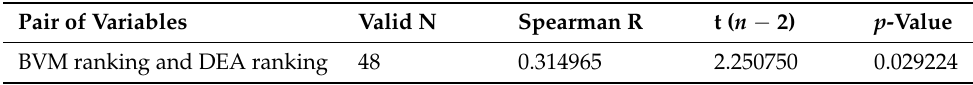
Table 4. Spearman’s Rank Order Correlation. Pair of